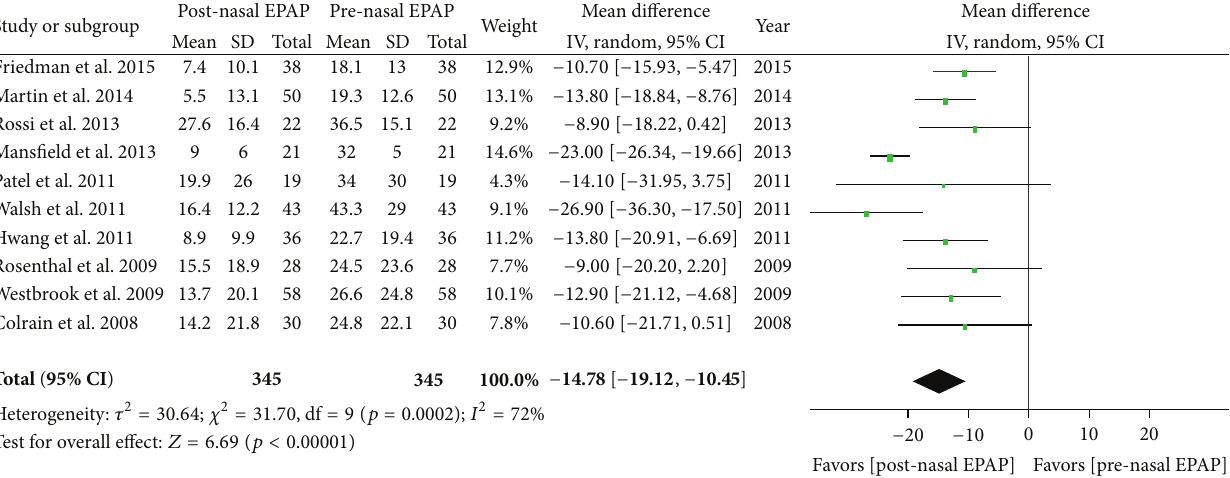
Figure 2: Pre- and post-nasal EPAP therapy outcomes for apnea-hypopnea index (events per hour), mean difference. SD: standard deviation; CI: confidence interval; nasal EPAP device: nasal expiratory positive airway pressure device (Provent).